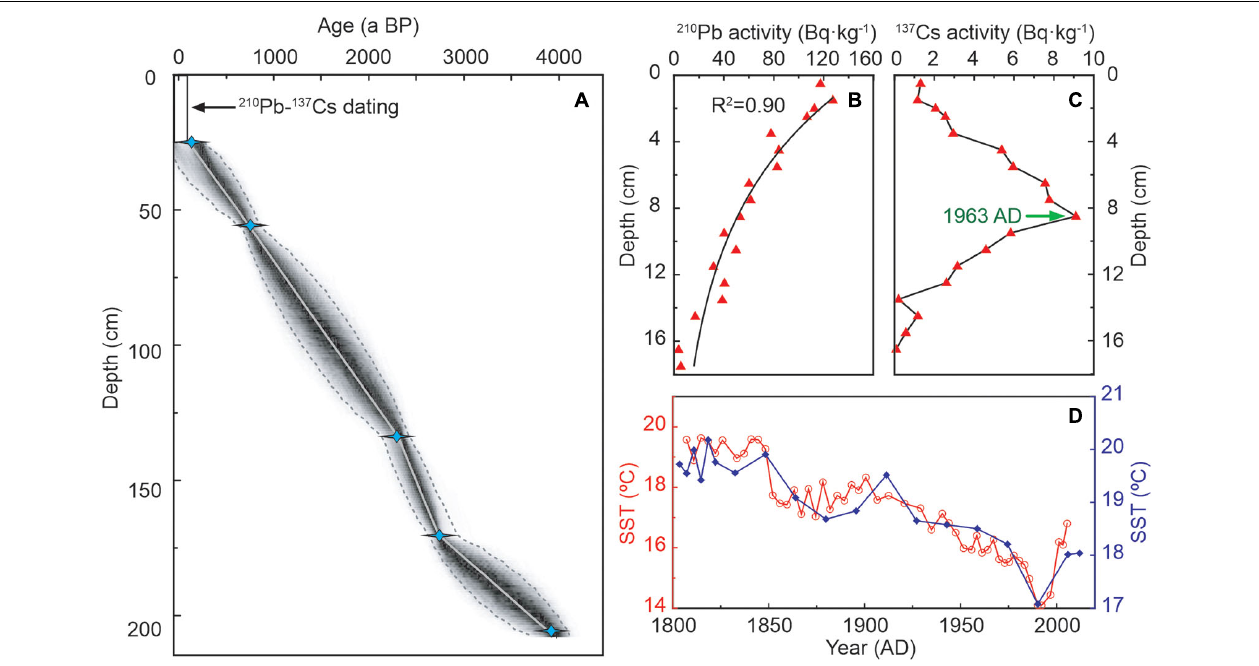
FIGURE 2 | Chronology of gravity Core 38002-A and box Core 38002. (A) 14 C age for Core 38002-A (Zhang et al., 2019), (B,C) 210 Pb and 137 Cs activities for Core 38002 (Zhou et al., 2012), (D) Comparison between SSTs from Cores 38002 (red) and 38002-A (blue) (Zhang et al., 2019).